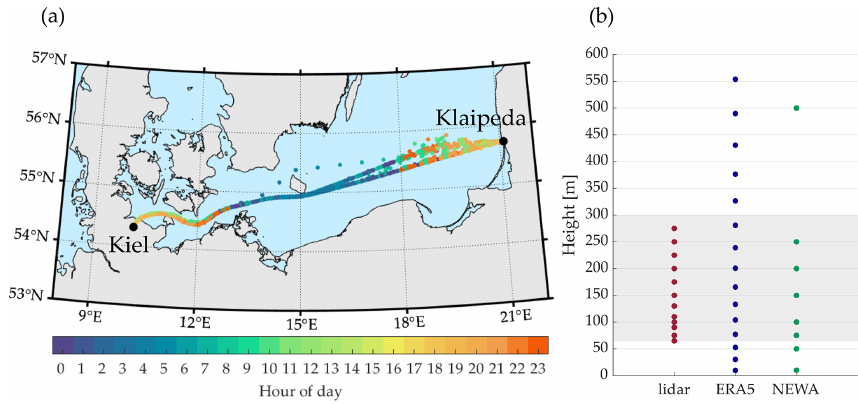
Figure 2. (a) Hourly averaged ship position during the execution of the measurement campaign. The hour of the day for each position is indicated by the color scale. (b) Retrieved heights for each dataset. For ERA5, the shown heights are the mean heights of the model levels. The shadowed area represents the bottom and top limit heights of vertical profiles used for LLJ detection in this